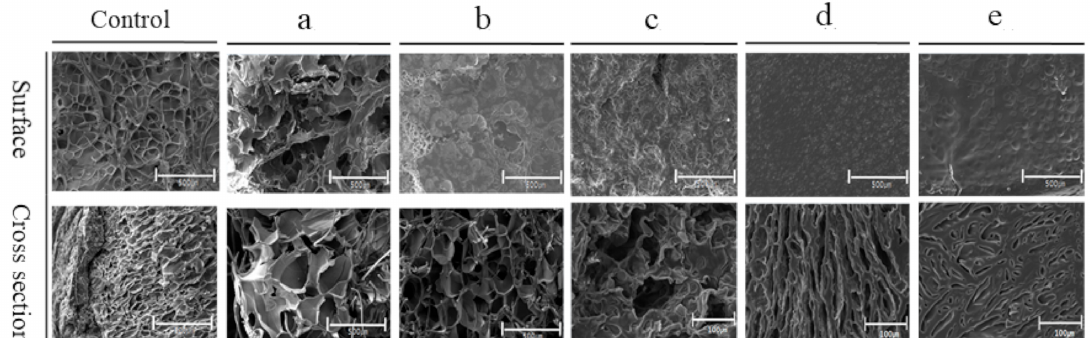
Figure 4. Morphologies of Centella asiatica extract-loaded hyaluronic acid-dextran hybrid patches by field emission scanning electron microscope analysis. Control: HA-Dex hybrid hydrogel patches with no CAE; ( a ) 9.8:0.2, ( b ) 9.6:0.4, ( c ) 9.4:0.6, ( d ) 9.2:0.8, and ( e ) 9:1 wt% HA-Dex: CAE (scale bars 5.0 kV × 5.0 K).